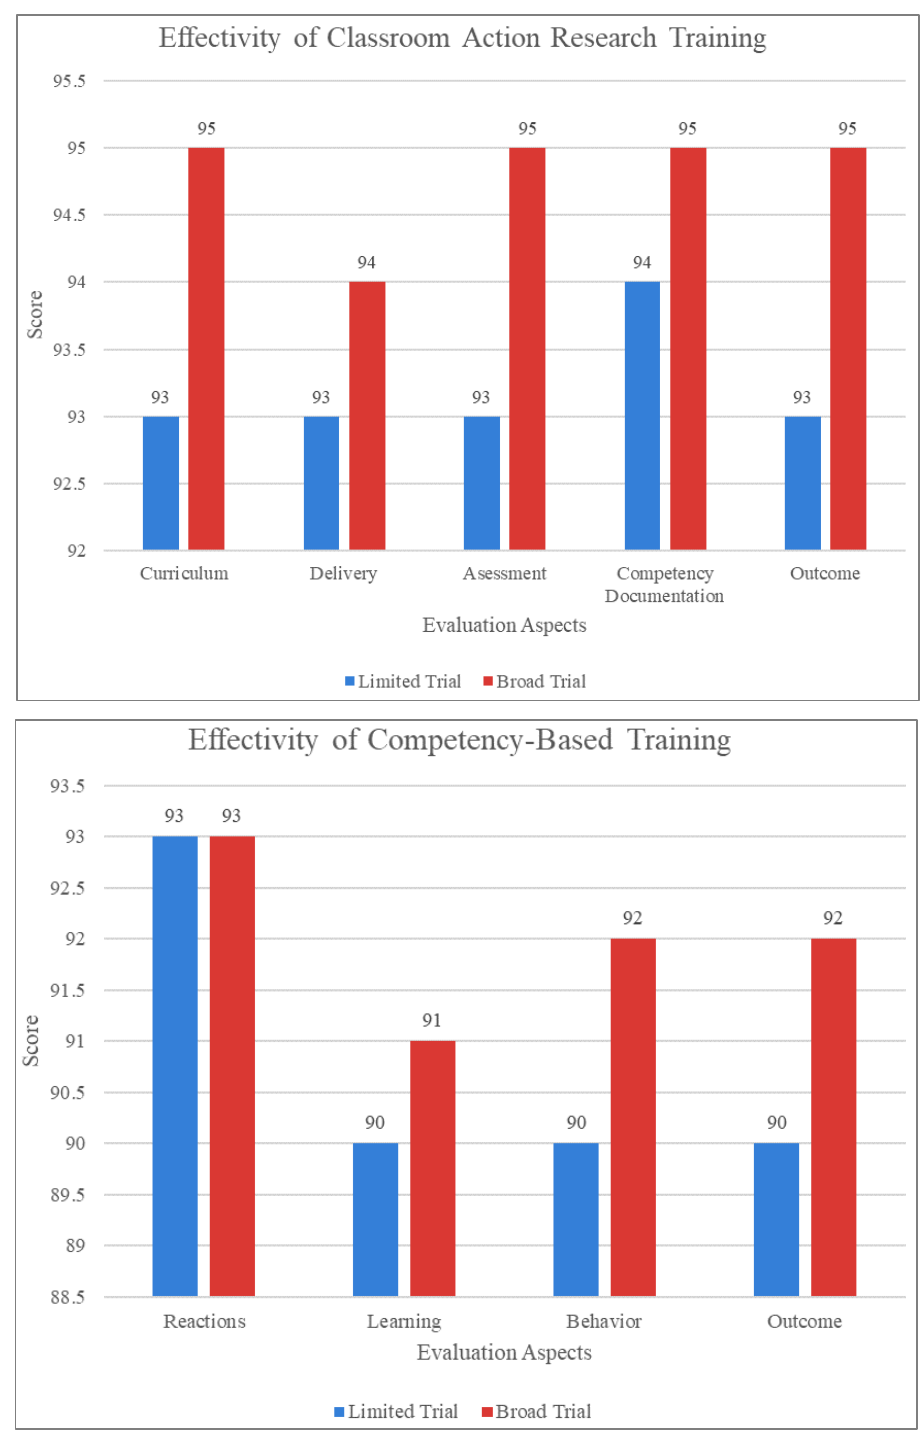
Figure 8. Effectivity evaluation in limited and broad